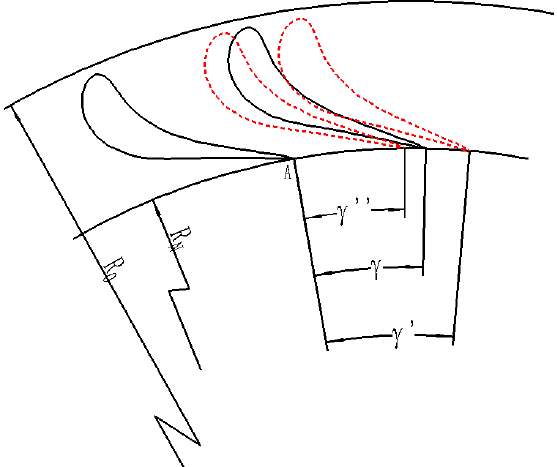
Figure 5. Changes in the number of stator